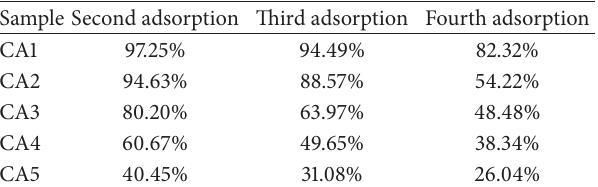
Table 3: Recovery of adsorption capacity of composite micro- spheres after